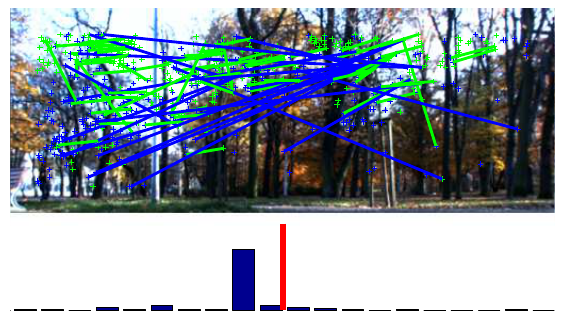
Figure 2. SURFnav navigation algorithm. Matched